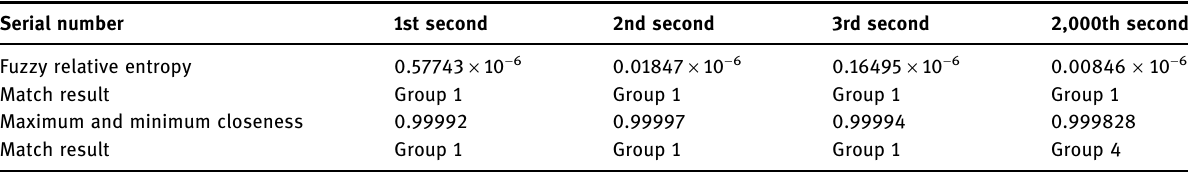
Table 3: Data matching results per